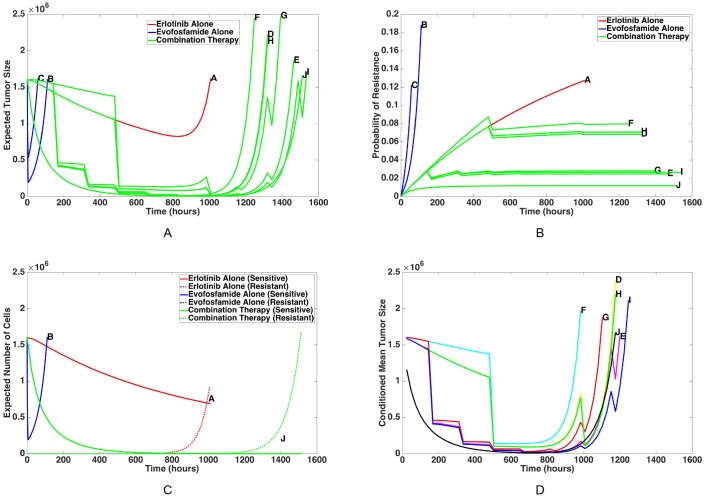
Tumor evolutionary dynamics over time, given a variety of single-agent and combination therapies.Mean tumor size (A) and probability of resistance (B) are calculated up to recurrence time for a tumor with an initial population of 1.6 ⋅ 106 sensitive cells undergoing treatment with each of the ten dosing schedules defined in Table 3. Each labeled curve corresponds to the dosing schedule with the matching letter in Table 3. For the sake of comparison, results due to dosing schedules using erlotinib alone are shown in red, results due to dosing schedules using evofosfamide alone are shown in blue, and results due to combination therapies are shown in green. Mean tumor size for one of each of these three types of dosing schedules is broken down into the means of sensitive and resistant cells in (C). (D) shows the expected tumor size for combination strategies, conditioned upon the event of developing resistance.